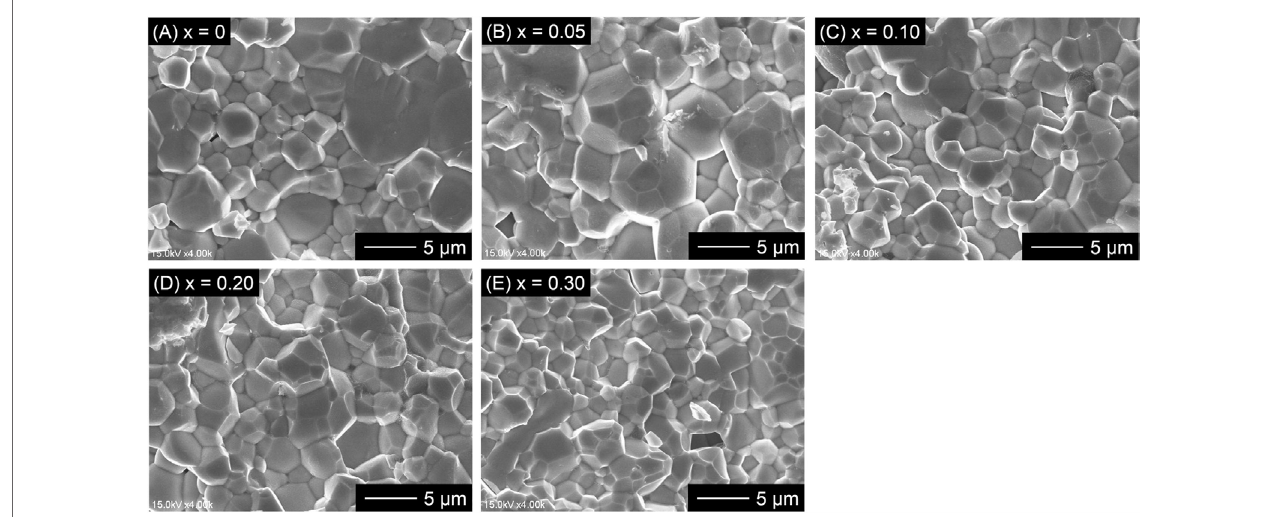
FigUre 4 | comparison of seM images for fractured cross section of llBZT with different Ba contents x : (a) x = 0, (B) x = 0.05, (c) x = 0.10, (D) x = 0.20, and (e) x = 0.30